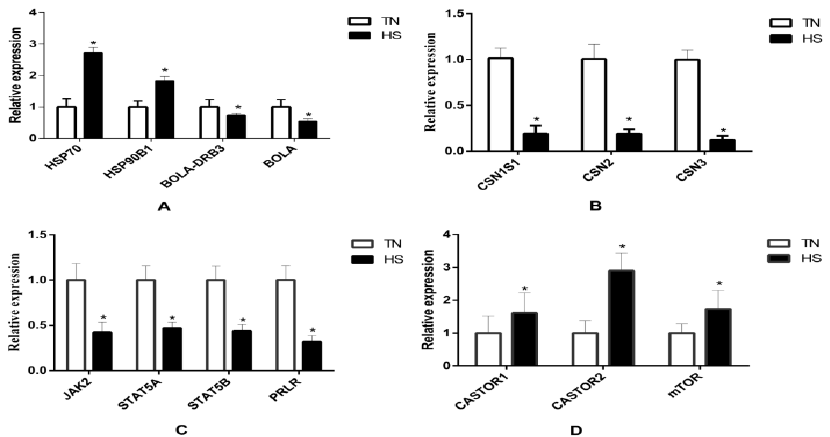
Figure 5. The relative expression of heat shock and immune response genes ( A ), casein genes ( B ), JAK/STAT5 pathway genes ( C ), and mTOR pathway genes between both TN and HS groups ( D ). * p < 0.05 vs. TN group.